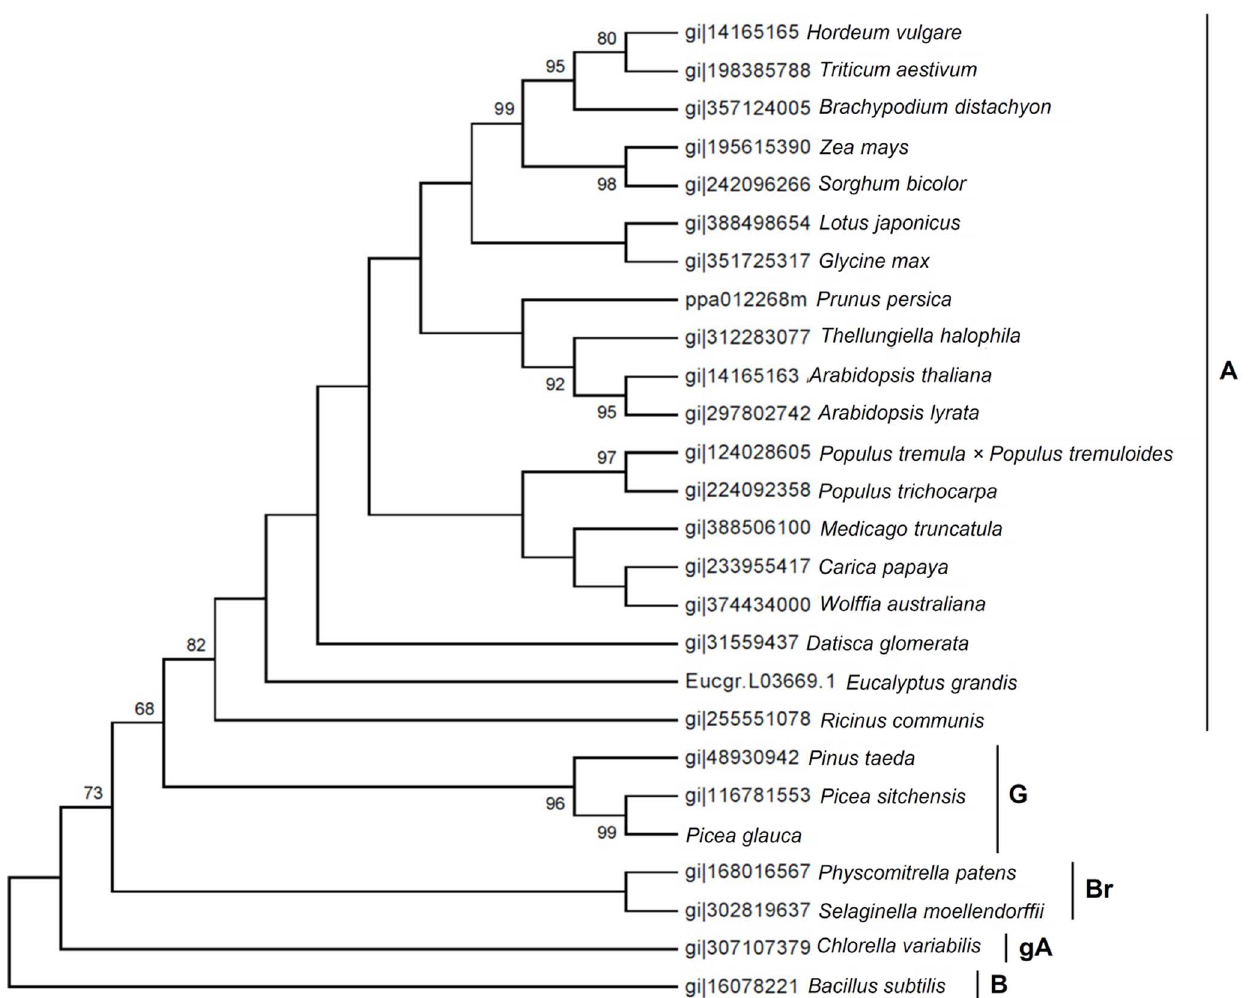
Figure 3. Phylogenetic analysis of plant truncated hemoglobin (TrHb) proteins with significant bootstrap values. A: angiosperms, B: bacteria, Br: bryophytes, G: gymnosperms, gA: green alga.